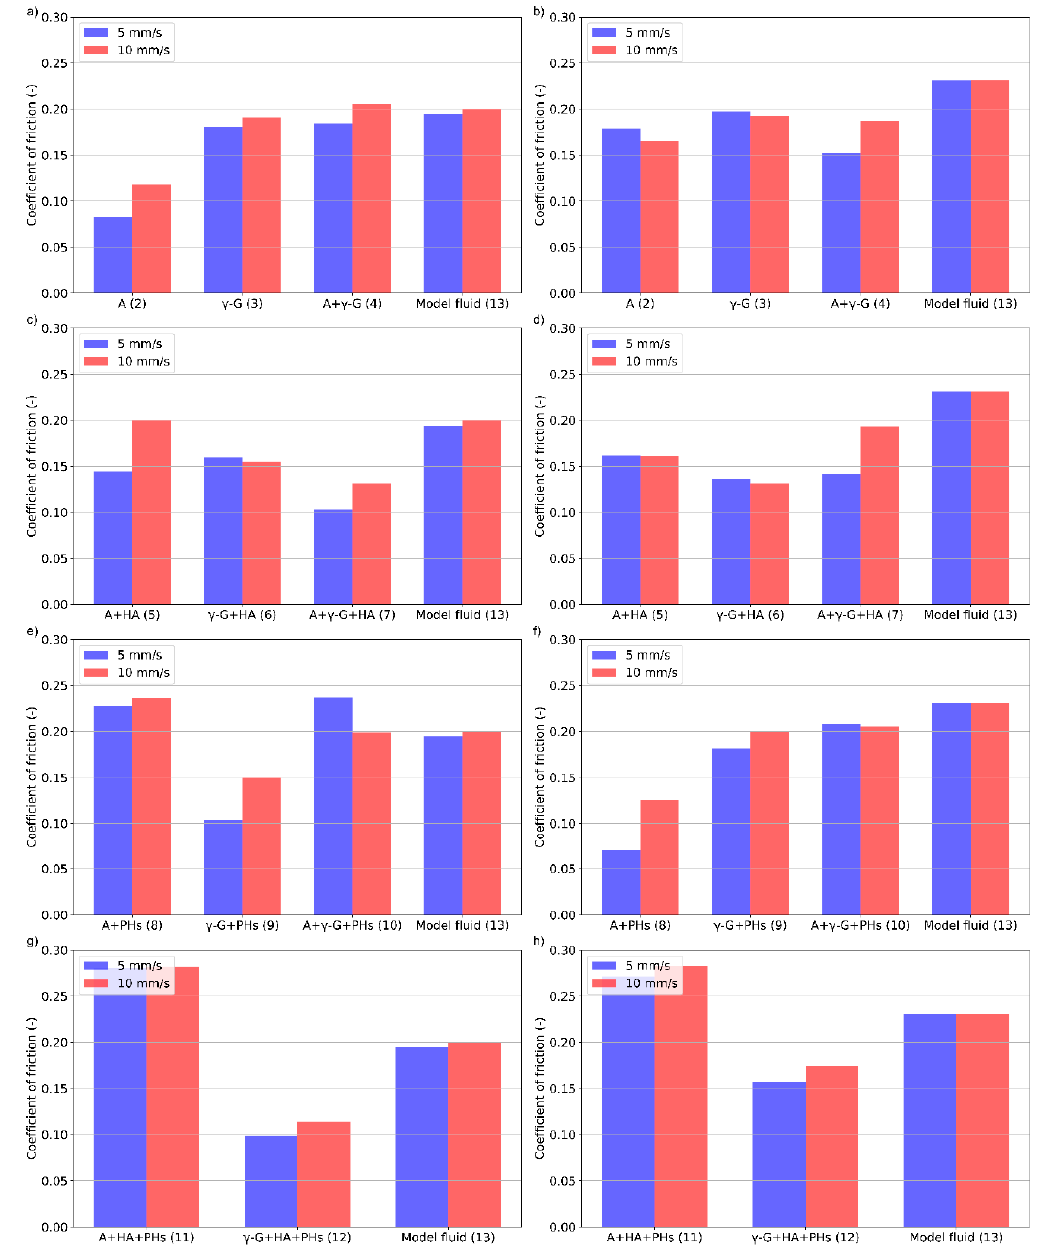
Figure 5. The e ff ect of speed on the friction coe ffi cient for various protein- ( a , b ), HA- ( c , d ), PHs- ( e , f ), Figure 5. The effect of speed on the friction coefficient for various protein- ( a , b ), HA- ( c , d ), PHs- ( e , f ), and HA + PHs- ( g , h ) based lubricants; PC ( left ) and OC ( right and HA + PHs- ( g , h ) based lubricants; PC (left) and OC (right).